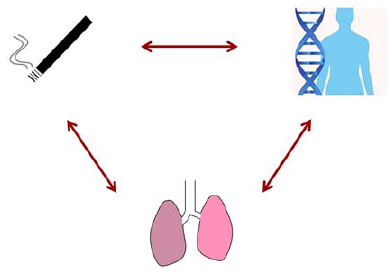
Figure 1. In this issue of PLOSGenetics , Hancock et al. address gene–environ- ment interaction effects based on smok- ing status, GWAS data, and lung func- tion outcomes in over 50,000 adults. This Perspective highlights the main findings in Hancock et al. [11] and discusses why interaction effects are so difficult to identify even in large, well-characterized data sets.